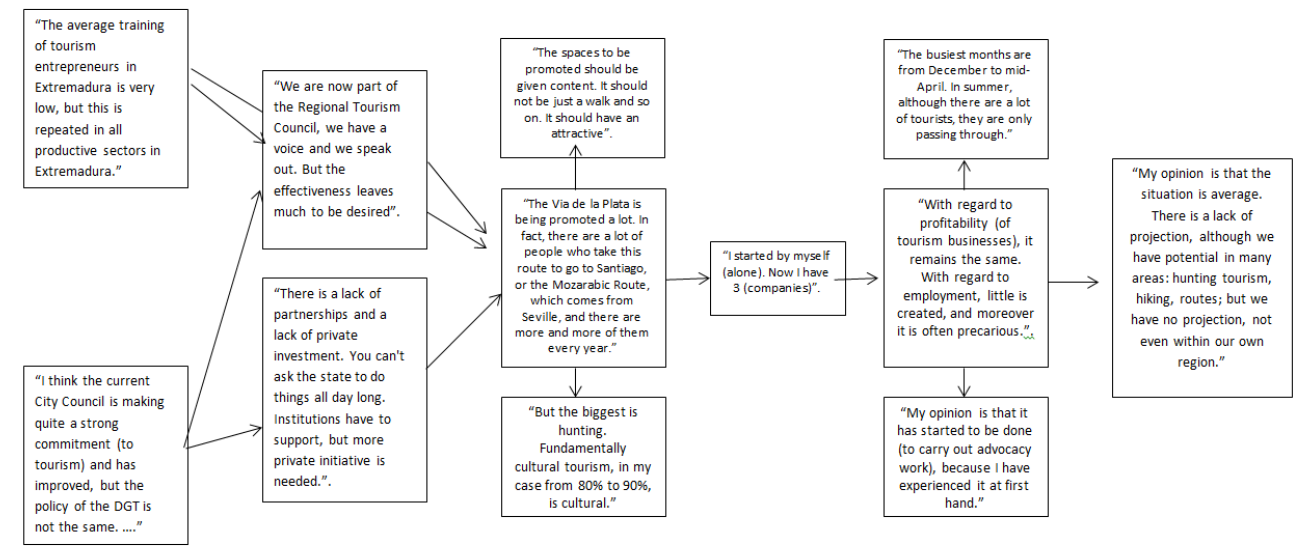
Figure 3. Relationship tree for the set of contributions from the focus groups in Extremadura. Source: own elaboration.